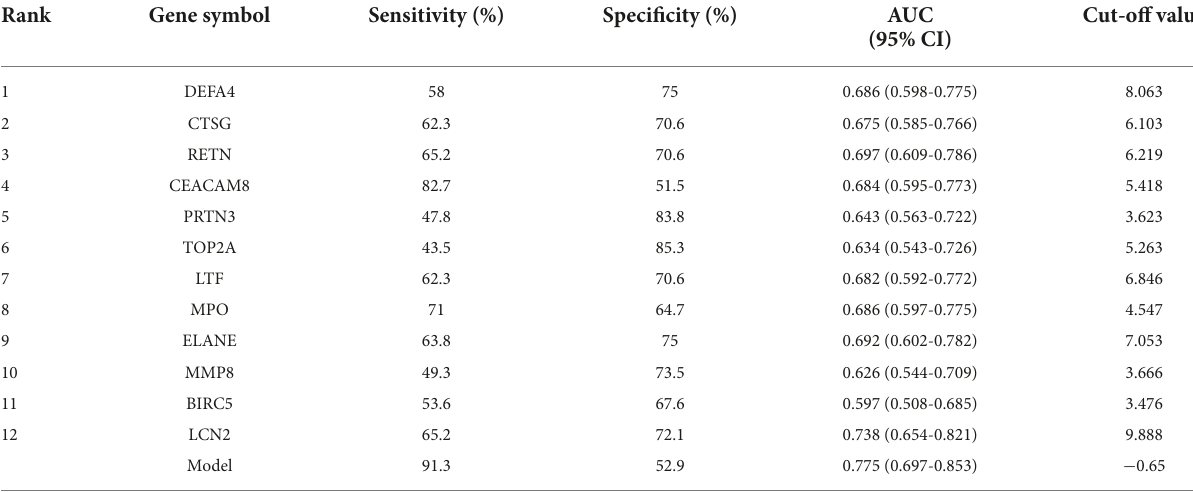
TABLE 5 The sensitivity, specificity, and AUC of the 12 verified hub genes in detecting renal involvement in SLE. Rank Gene